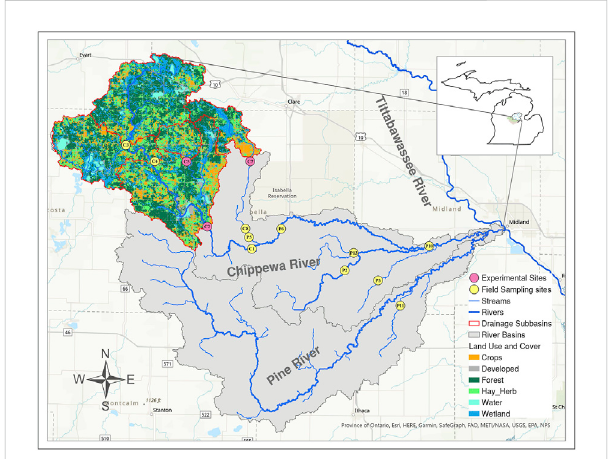
FIGURE 1 A map of the Chippewa River watershed that feeds the Tittabawassee River, and ultimately draining to coastal Lake Huron (Michigan, United States). The map depicts the 14 sampling points (colored circles), with the three experimental sites highlighted (pink-colored circles). Percent land use for the associated drainage subbasins was been delineated (forest, agriculture, and urban) where nutrient enrichment experiments were performed within the